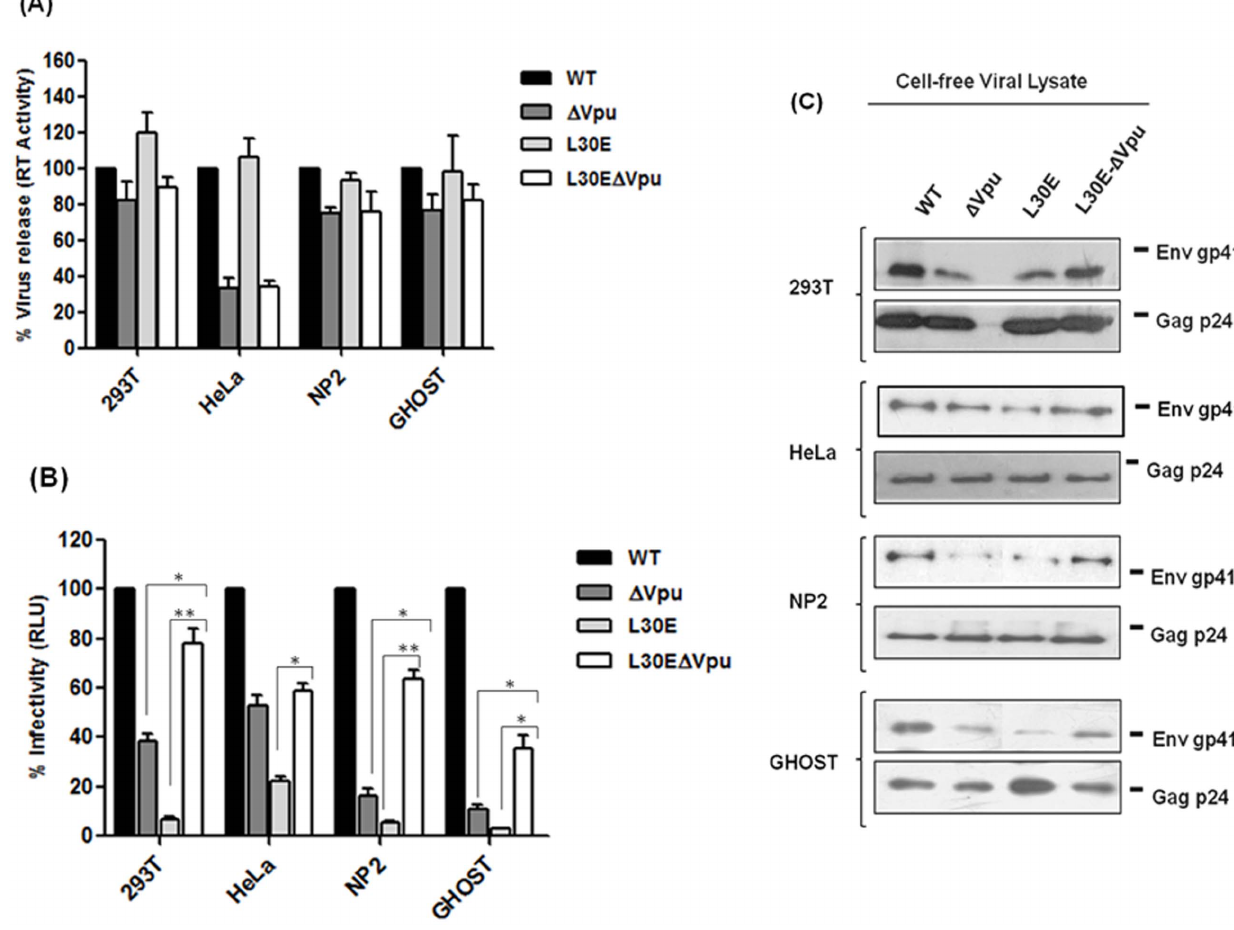
Figure 3. Vpu start codon mutation rescued infectivity of defective Gag MA mutant (L30E) viruses by modulating Env incorporation on released virions. (A) 293T, HeLa, NP2 and GHOST cells were transfected with four different plasmids (WT, D Vpu, L30E and L30E- D Vpu). WT and D Vpu were used in each experiment of this study as control. At 48 h post-transfection, supernatants were collected and the level of virus release in supernatants was determined by RT ELISA. Percent RT activity and standard error was calculated with respect to WT assuming WT infectivity as 100%. (B) Infectivity of released virions was assessed in TZM-bl indicator cells. Viruses normalized for equal RT were added on TZM-bl cells. After 48 h, infectivity was determined by measuring Luciferase activity. The average of RLU and standard error was calculated. WT infectivity was considered as 100%. Significance in the increased infectivity of double mutant viruses (L30E- D Vpu) was determined with respect to L30E and D Vpu viruses using Student’s t -test: * means p , 0.05 and ** means P , 0.005. (C) Western blots shown represent cell-free viral proteins. Viral supernatants were concentrated by ultracentrifugation using 20% sucrose cushion and viral proteins were analyzed by western blotting using anti-p24 (183-H12-5C) and anti-gp41 (Chessie 8) antibodies. Virus release and infectivity experiments were performed in duplicates and the results shown are representative of three independent experiments. For western blot analysis, the viral supernatants of three independent experiments were pooled, concentrated, normalized for RT values and run in 10% SDS-PAGE